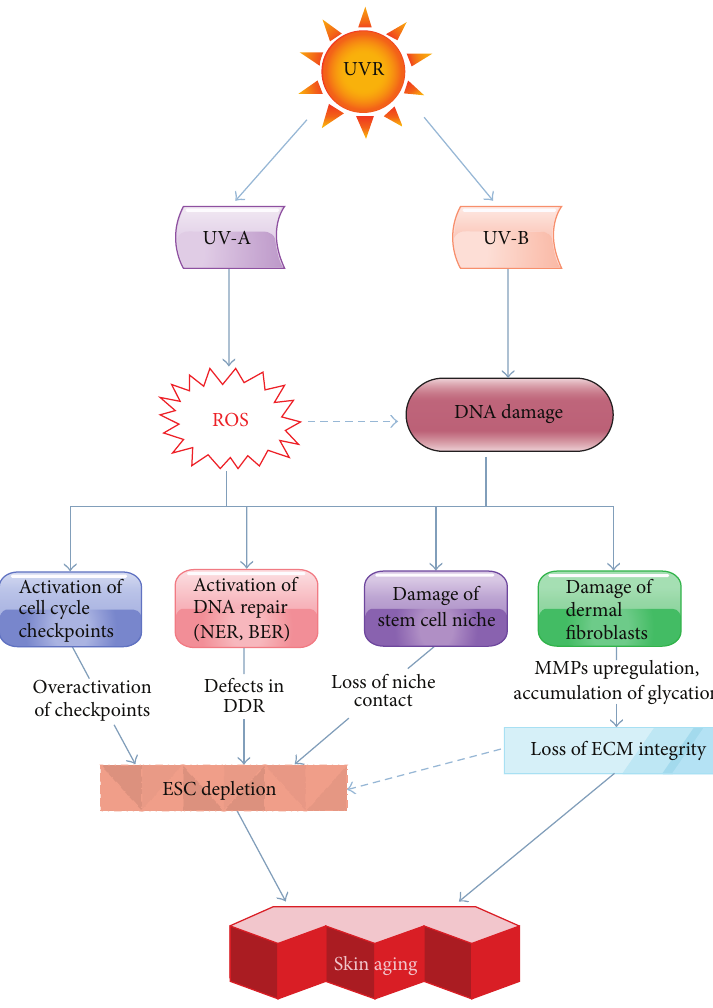
Figure 1: Skin aging induced by UVR-induced DNA damage to ESCs. UVR is the major skin stressor capable of damaging ESC DNA (UV-B) or promoting production of the DNA toxic ROS (UV-A). DNA damaging effects of UVR result in activation of cell cycle arrest (checkpoint activation) and DNA repair proteins, damaged stem cell niche, and dermal fibroblasts. These facilitate ESC depletion and loss of extracellular matrix (ECM) integrity, leading to premature skin